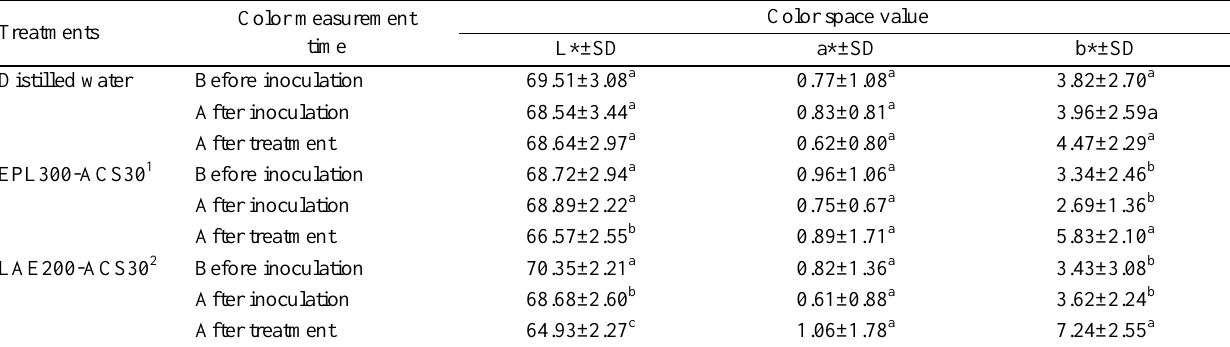
Table 2. Mean L*a*b* color values of chicken carcasses for before inoculation, after inoculation and after treatment